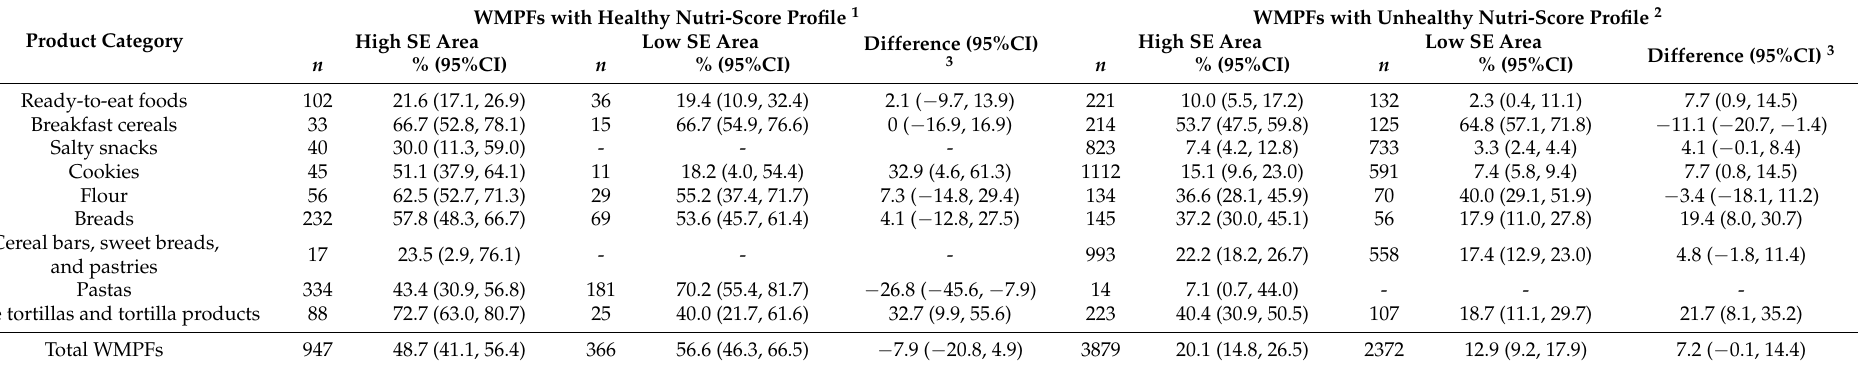
Table 5. Difference in the percentage of healthy and unhealthy wheat and maize processed foods (WMPFs) displaying health and nutrition claims on the front of the package by socioeconomic (SE)